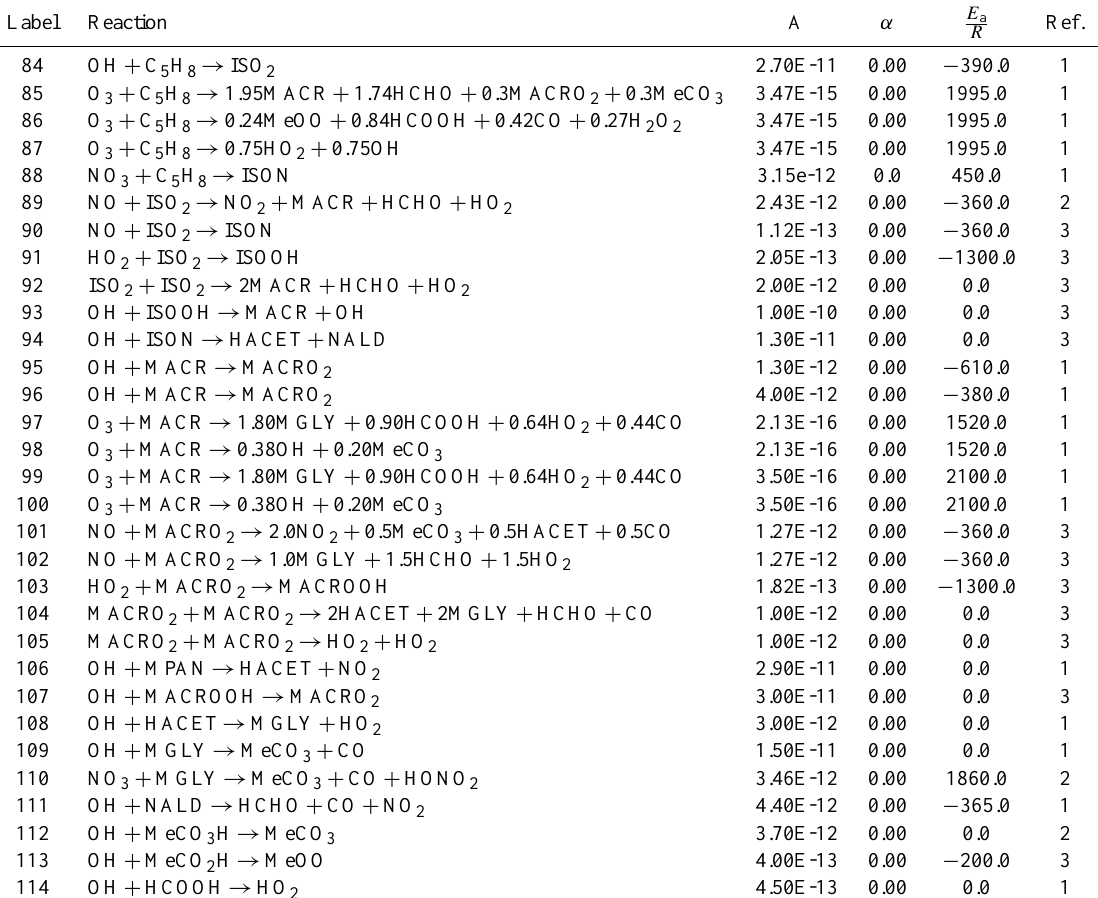
(cid:17) (cid:17) α (cid:16) − E (cid:16) T a , where A is the pre-exponential factor, T exp RT 300 (cid:16) T (cid:17) temperature dependence, and E a is the Arrhenius activation energy. 300